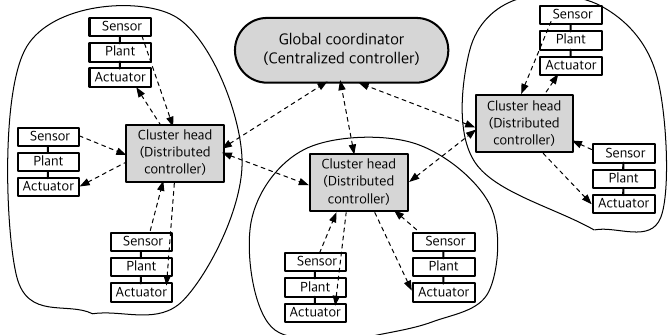
Figure 1. General structure of wireless networked control systems. Multiple plants are controlled by multiple controllers. A wireless network closes the loop from sensor to controller and from controller to actuator. The network includes sensors and actuators attached to the plants, cluster heads, and global